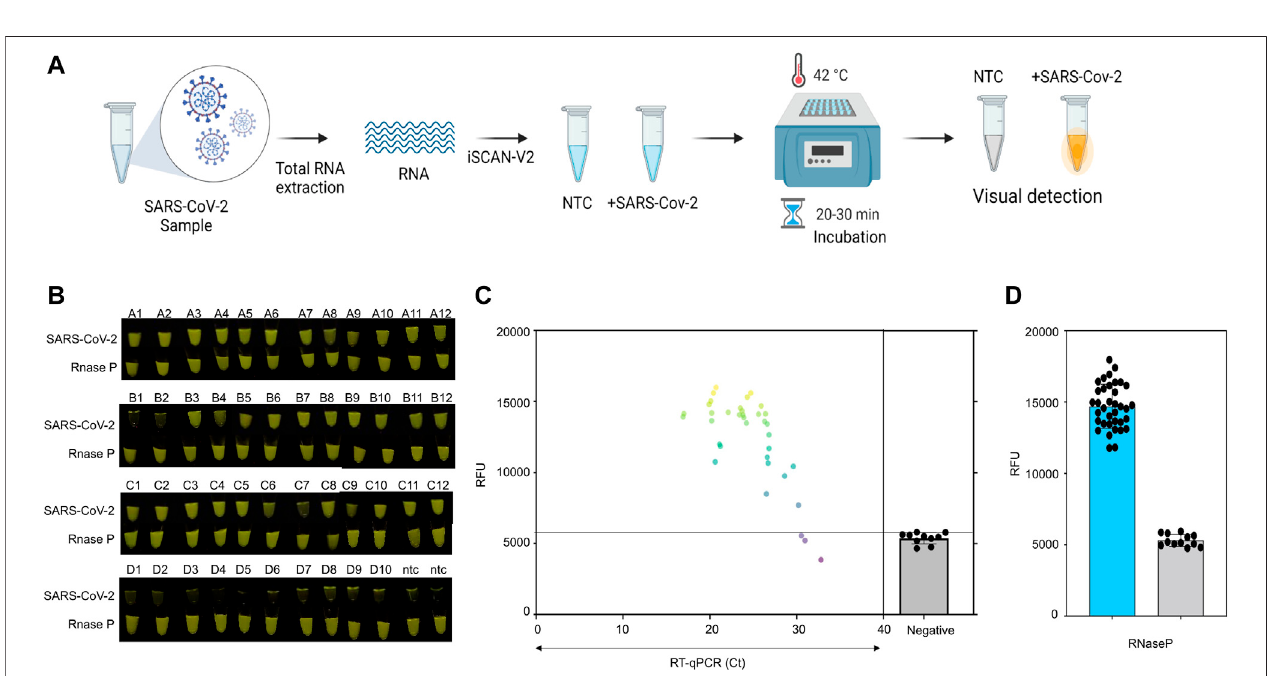
FIGURE7| ClinicalvalidationofiSCAN-V2. (A) SchematicofiSCAN-V2validationforSARS-CoV-2detectioninclinicalsamples. (B) iSCAN-V2-basedSARS-CoV- 2 detection in clinical samples. Total RNA extracted from clinical samples [positive samples ( n (cid:1) 36) and negative samples ( n (cid:1) 10)] was subjected to the iSCAN-V2 platform for SARS-CoV-2 detection. RNaseP was used as the internal control for each sample. (C) Correlation of iSCAN-V2-based fl uorescence readouts for SARS- CoV-2 detection with RT-qPCR cycle threshold (Ct) values in clinical samples. The grey line represents the background fl uorescence in the negative samples. (D) End-point fl uorescent readouts of RNaseP used as an internal